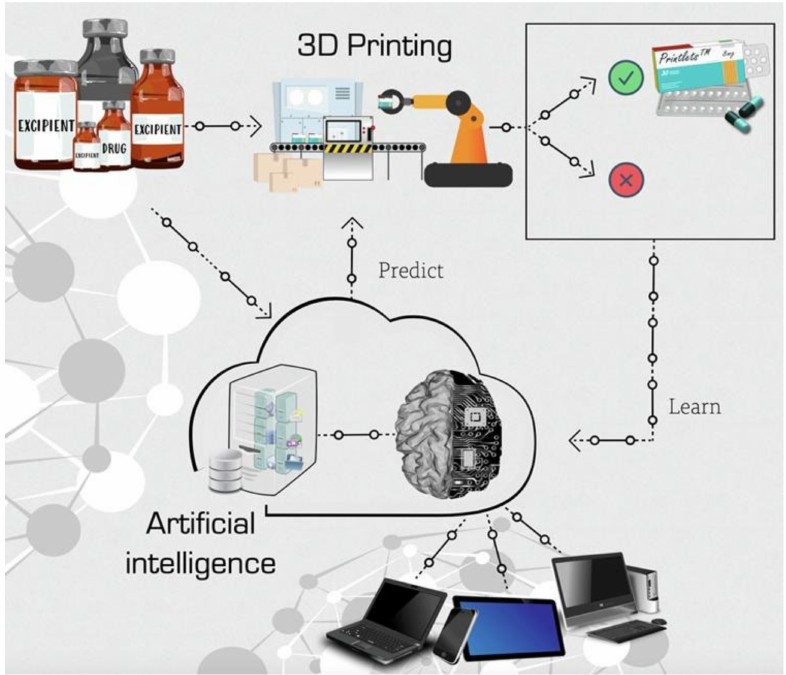
Figure 5. Machine learning approach for predicting the 3D printability of medicines (M3DISEEN).